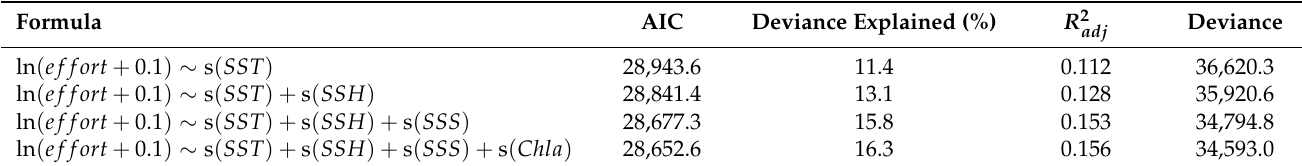
Table 6. Statistical parameters of GAM model (0.5 ◦ × 0.5 ◦ , not latitude and longitude). Formula AIC Deviance Explained (%) R 2